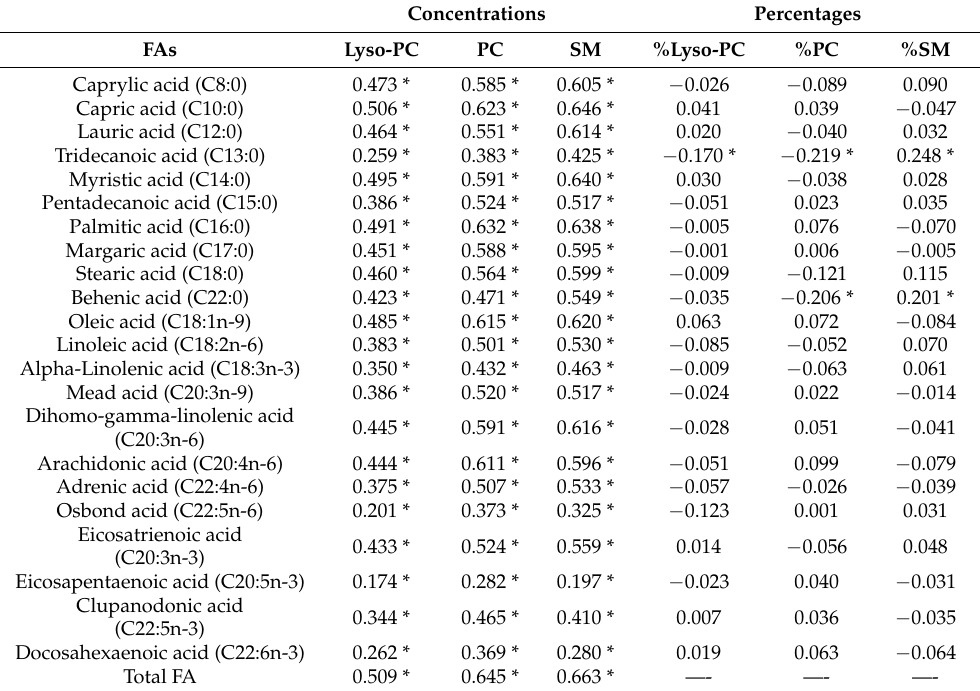
Table 2. Pearson’s correlation coefficients of total FA concentrations (g/L) and percentages with subclasses of PL concentrations ( µ mol/L) and